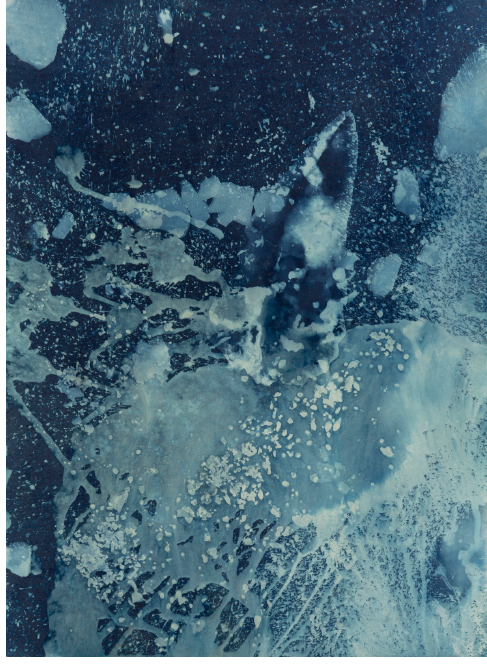
Figure 6: Downwaste (Sperry II), 2019. Cyanotype on paper 30" x 22". Courtesy of Jonathan Marquis. Downwaste gallery available at: